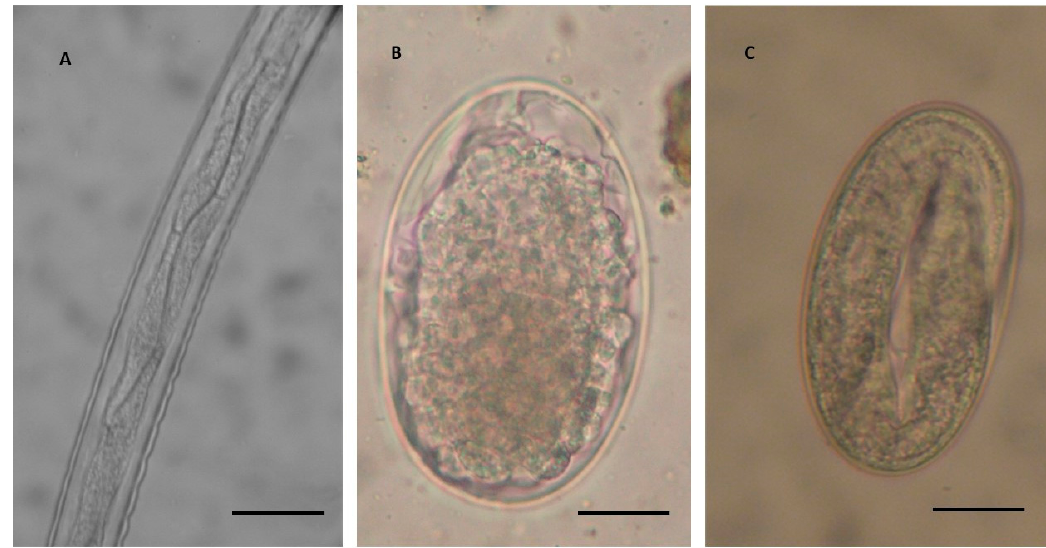
Figure 1. Detail of the body of third stage larvae (L3) of cyathostomin ( A ), showing eight intestinal cells of which the first four are arranged in a double row and the second group of four cells are in a single line (magnification 400 × ). This typology of L3 was identified as Cylicostephanus spp. ( Cylicostephanus hybridus, Cylicostephanus calicatus and Cylicostephanus longibursatus ) according to Bevilaqua et al. [19], and as type C L3 according to Santos et al. [21]. Scale bar: 50 µ m. ( B ) Undeveloped cyathostomin egg and ( C ) developed cyathostomin egg containing a first stage larva (magnification 400 × ). Scale bars: 20 µ m.